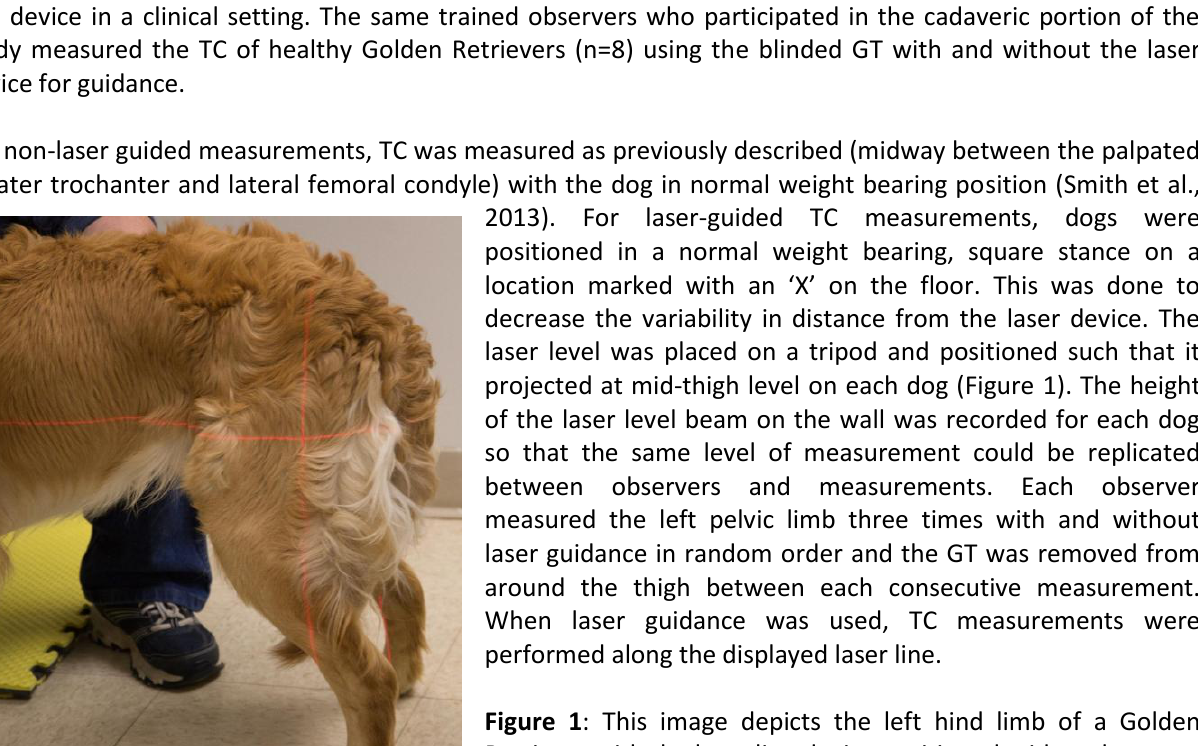
Figure 1 : This image depicts the left hind limb of a Golden Retriever with the laser line device positioned midway between the greater trochanter and the lateral femoral condyle to guide